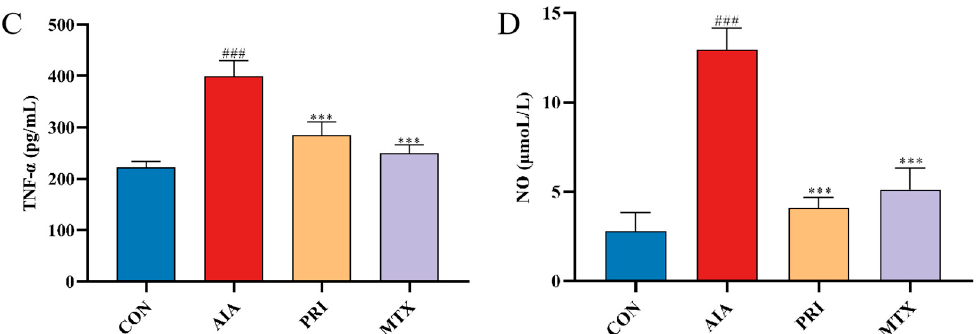
Figure 5. Effects of PRI on paw swelling ( A ), arthritis scores ( B ), serum levels of TNF- α ( C ) and NO ( D ) of AIA rats. All the data were expressed as mean ± SD, *** p < 0.001 compared with AIA group, ### p < 0.001 compared with CON group.